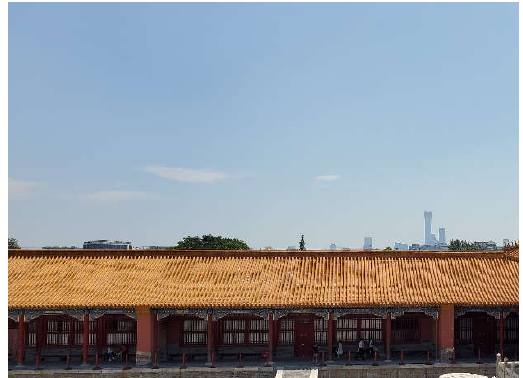
Figure 2 An architectural heritage and its